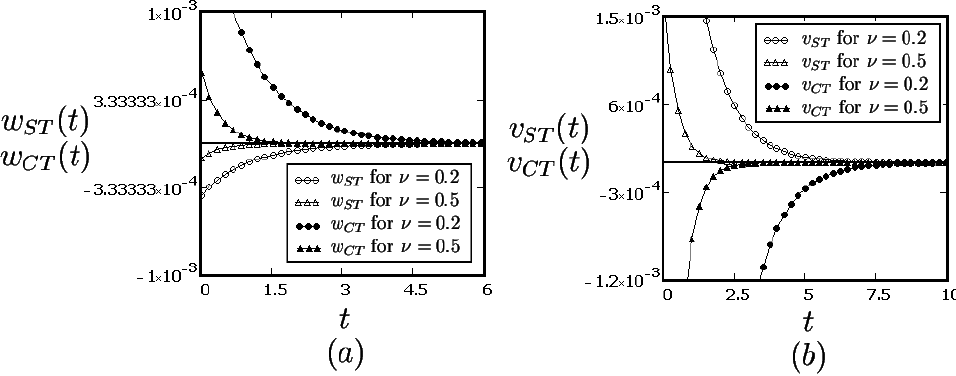
Fig. 2. Decay of the transient components w ST ( r , t ) , w CT ( r , t ) , v ST ( r , t ) and v CT ( r , t ) given by Eqs. (42), (57), (43) and (58), for R 1 =